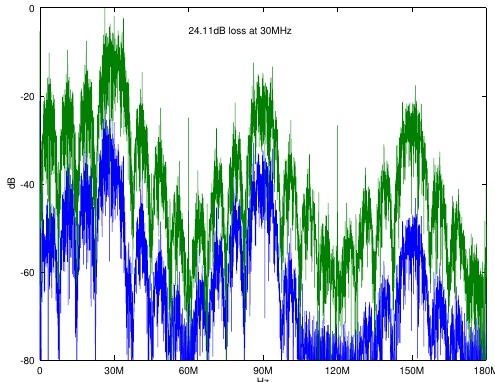
Figure 10: Spectrum plot of received signal (blue) and reference signal (green) at 30MHz through a male test subject’s arm with d = 22 . 5 cm